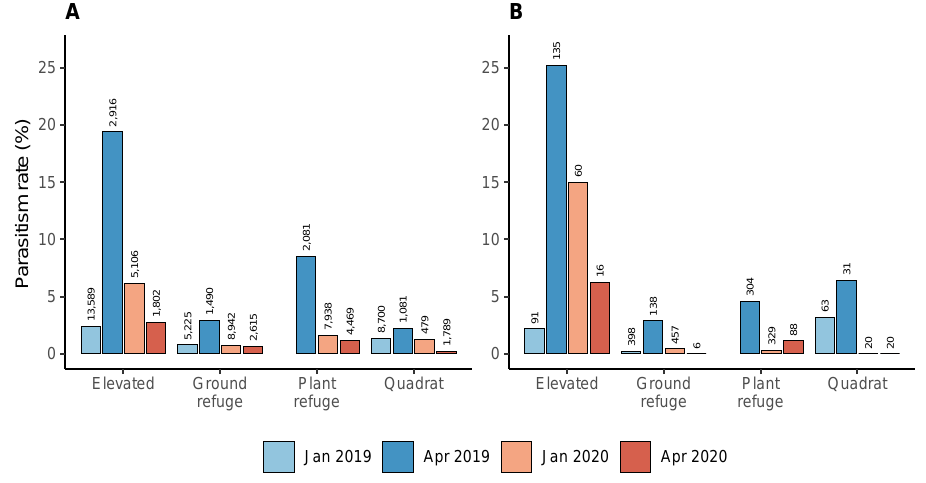
Figure 4. Total S. villeneuveana parasitism rates on: ( A ) C. acuta at 13 sites; and ( B ) C. barbara at 7 sites, by habitat and sampling date, with snail sample size shown above bars. Plant refuges were not sampled in January